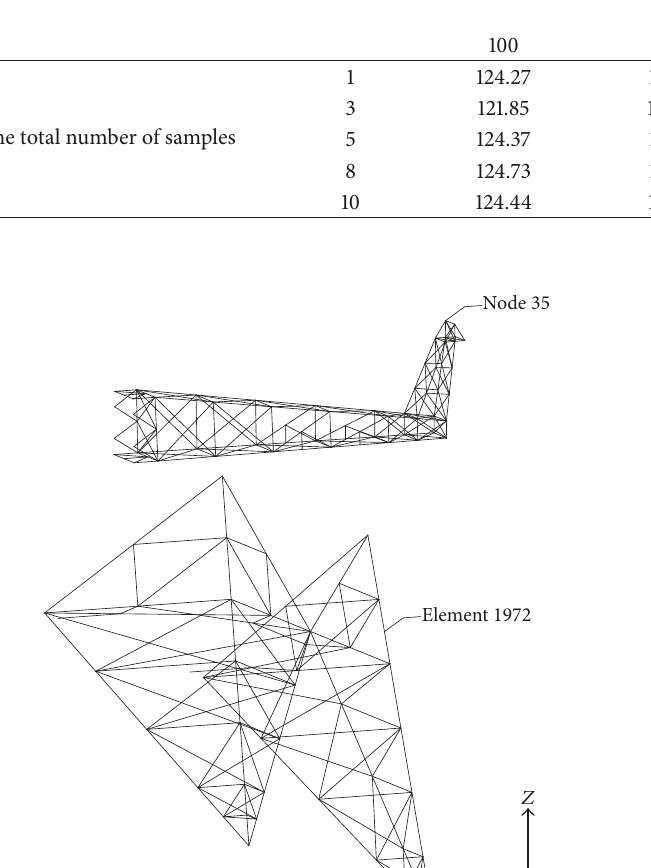
Table 4: The average of mean Ux displacement on tower top node 35# (mm).